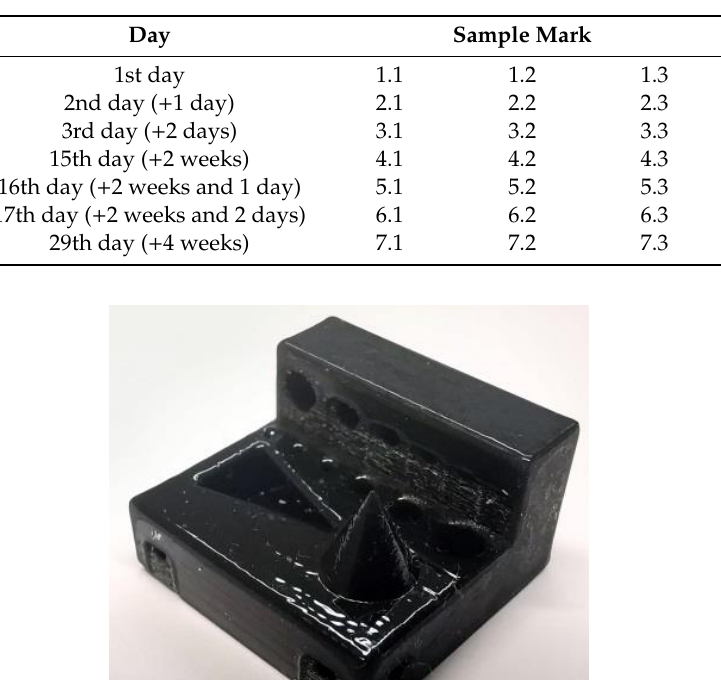
Table 1. Plan of printing by days.